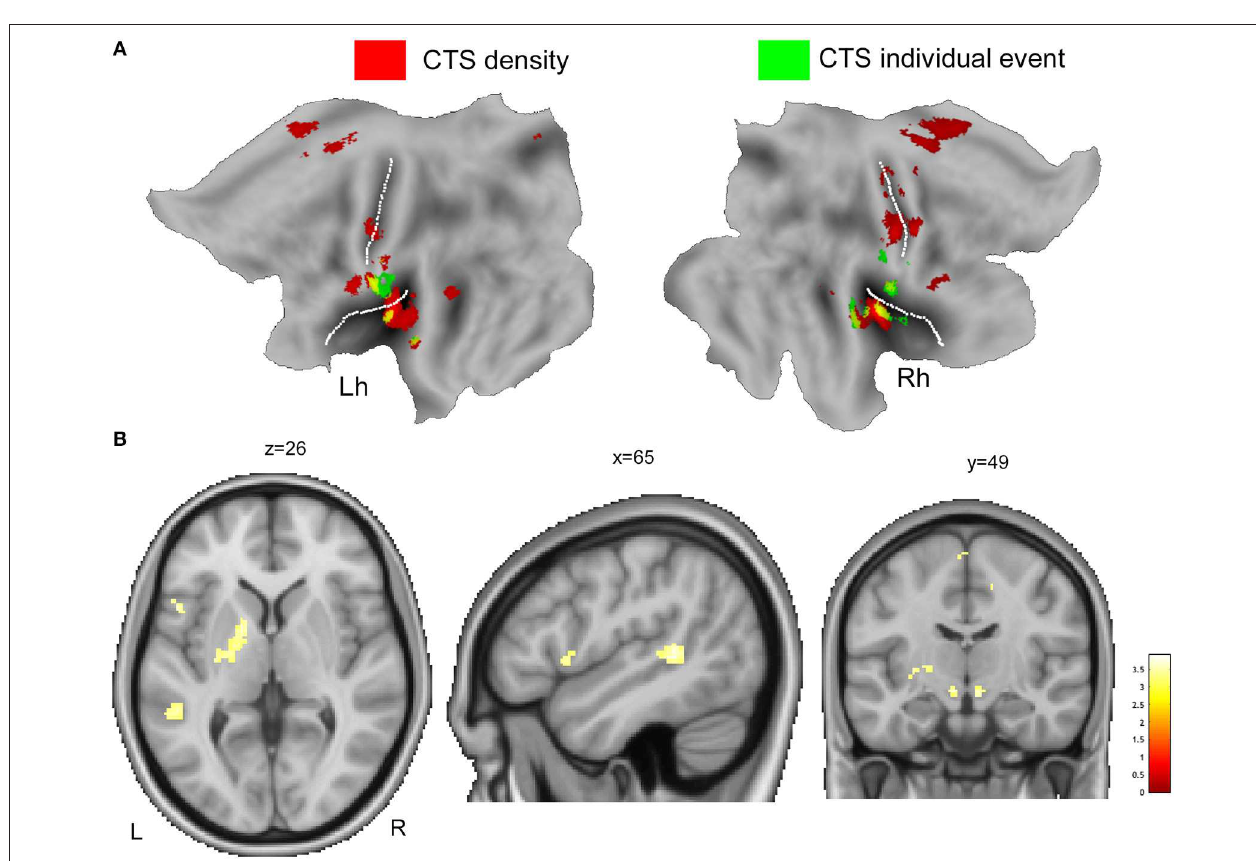
FIGURE 2 | (A) The overlaid of individual CTS model (green color) and CTS density model (red color) is displayed onto the flat template as implemented by Caret for left (Lh) and right hemisphere (Rh). (B) The main effect contrast derived from group-level density CTS > baseline analysis was exclusively masked by the mask contrast “individual CTS > baseline,” at a threshold of p < 0.05, uncorrected for multiple comparison. See text for details. Clusters of activations are overlaid into the canonical T1 0.5-mm image (coronal, axial, and sagittal slices) as implemented in FSL (FMRIB Software Library). R, right; L,